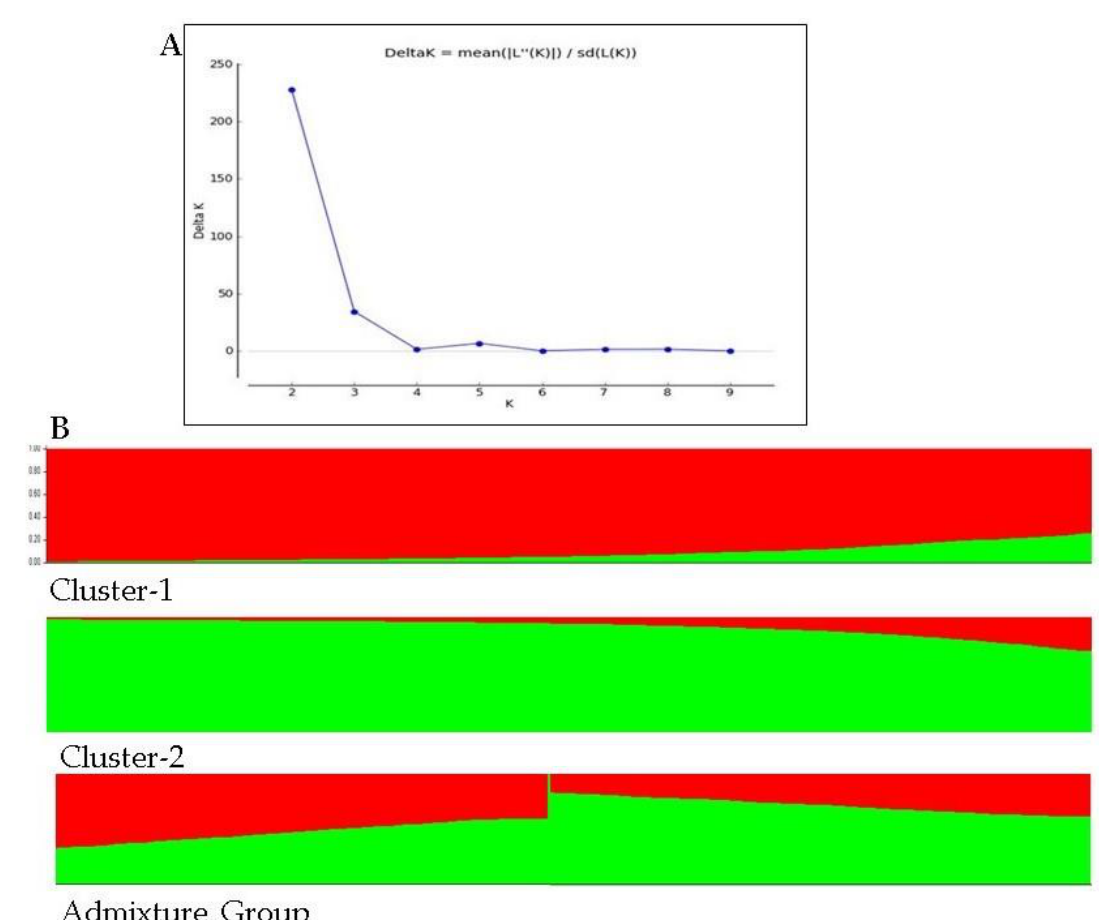
Figure 2. Population structure of safflower germplasm. ( A ) ∆ K reached maximum when K = 2 following the ad-hoc method. ( B ) Two population clusters with two subclusters in the second population inferred by STRUCTURE.